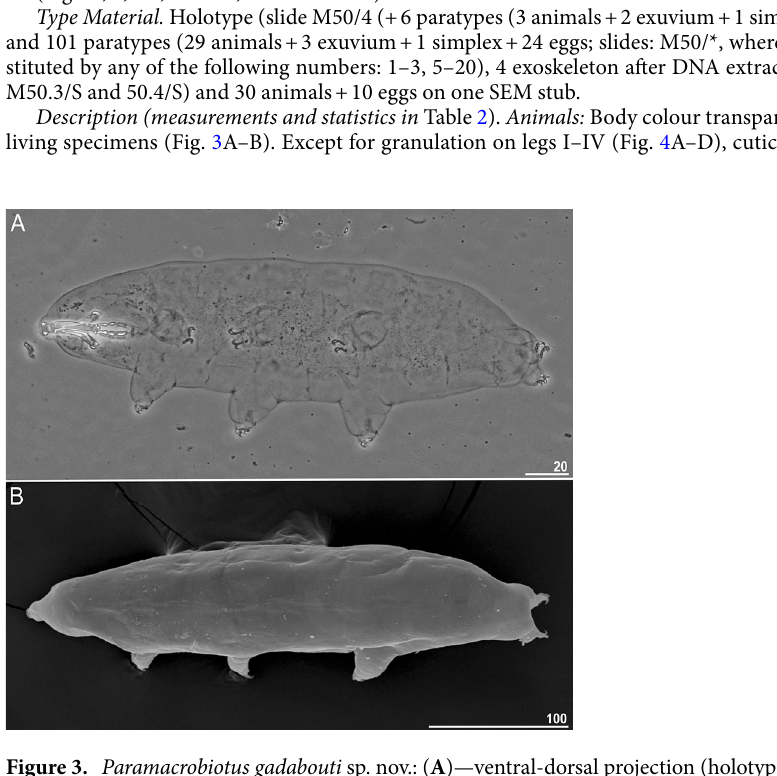
Figure 3. Paramacrobiotus gadabouti sp. nov.: ( A )—ventral-dorsal projection (holotype, PCM); ( B )—dorso- ventral projection (paratype, SEM). Scale bars in